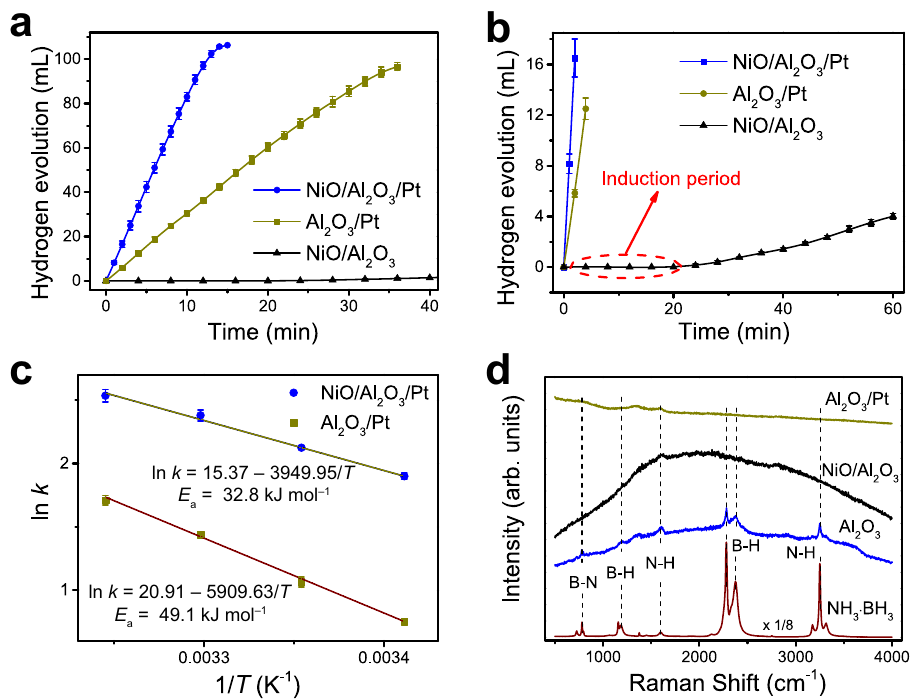
Fig. 2 Catalytic performances of catalysts for the dehydrogenation reaction of AB and Raman spectra for the used catalysts. a Volume of H 2 generated from AB solution (0.15 mol L – 1 ) at 25 °C catalyzed by NiO/Al 2 O 3 , Al 2 O 3 /Pt, and NiO/Al 2 O 3 /Pt. b The volume of H 2 generated at less than 18 mL versus prolonged time (60 min) clearly shows the induction period for NiO/Al 2 O 3 . c The Arrhenius plots for Al 2 O 3 /Pt and NiO/Al 2 O 3 /Pt. Error bars correspond to the standard deviation of three independent measurements. d Raman spectra for the used Al 2 O 3 support, NiO/Al 2 O 3 , and Al 2 O 3 /Pt after reaction for 10 min and data for the reference sample NH 3 ·BH 3